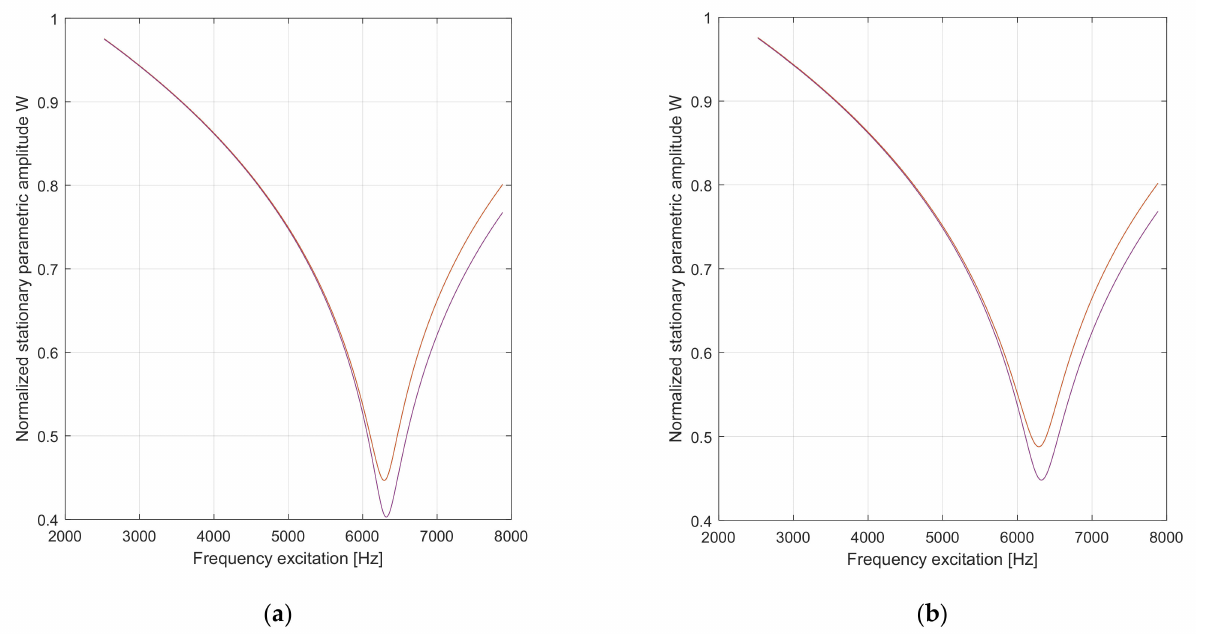
Figure 16. Normalized stationary parametric amplitude W of the bowl for χ nB = 0.10, where µ = 0.754 × 10 − 4 . ( a ) ζ = 0.0216 ( b ) ζ =